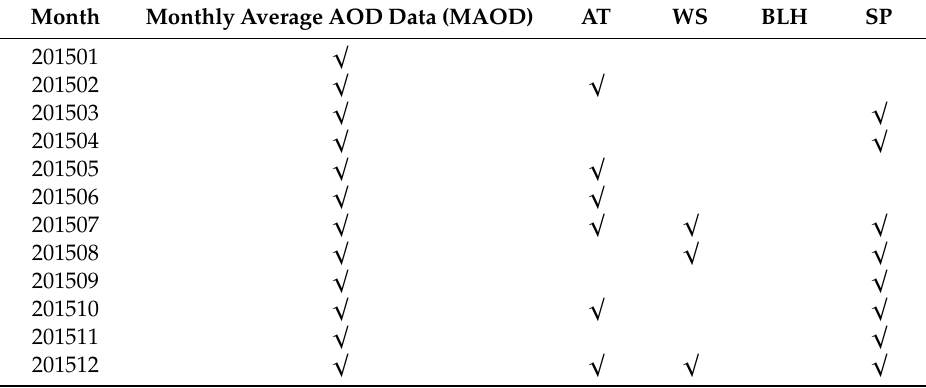
Table 2. Variable selection of monthly average PM 2.5 concentration (MAPC) estimation model for